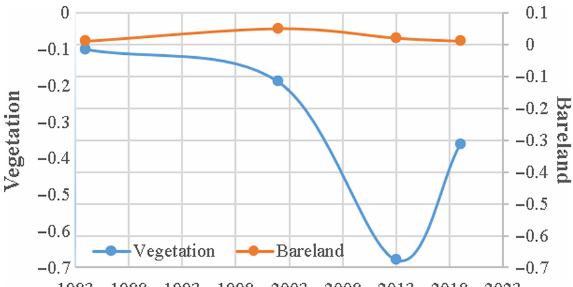
Fig. 12. CI plot of vegetation against built-up areas between 1984 and 2019.